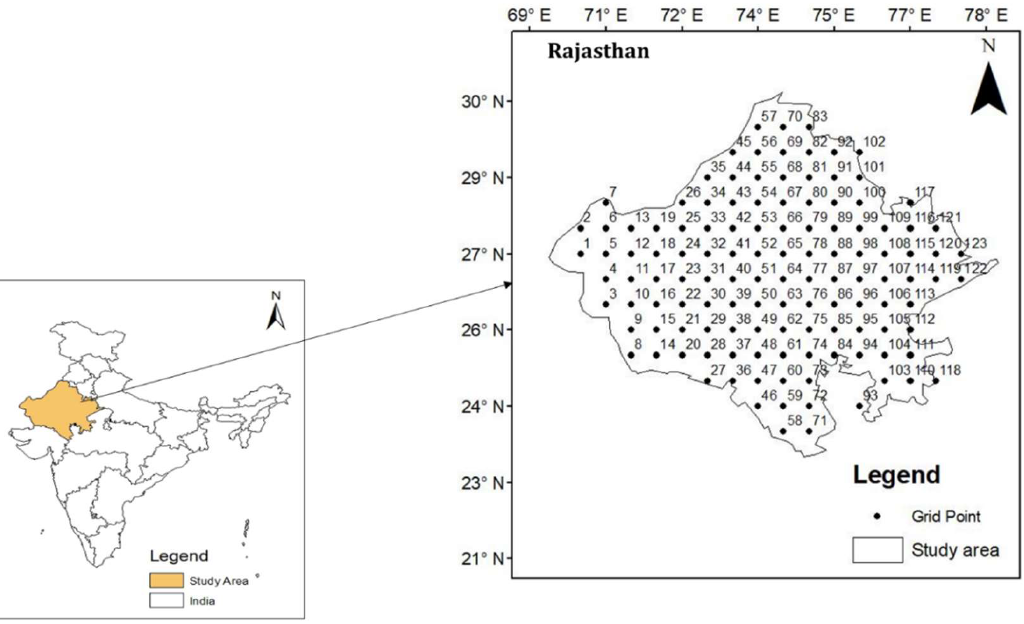
Figure 1. Location of study area (Rajasthan) and 123 Indian Meteorological Department grid